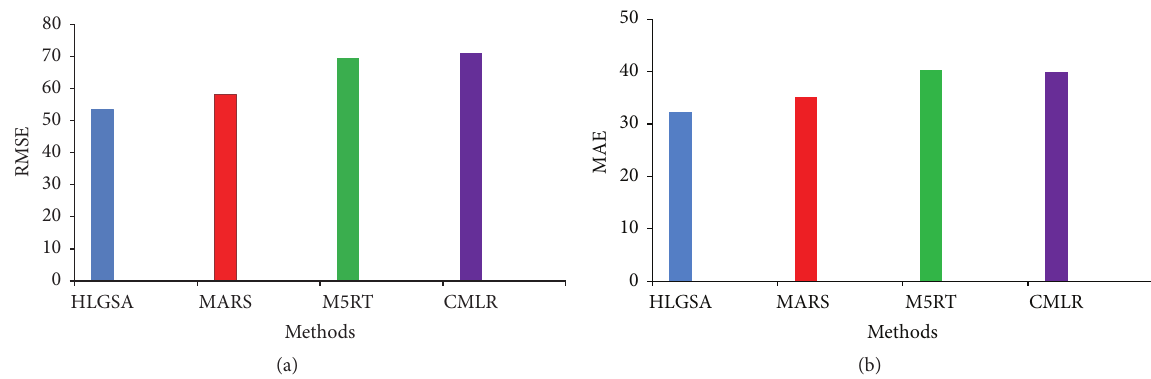
Figure 5: Overall errors of forecasted river flow using all normal models for Astore